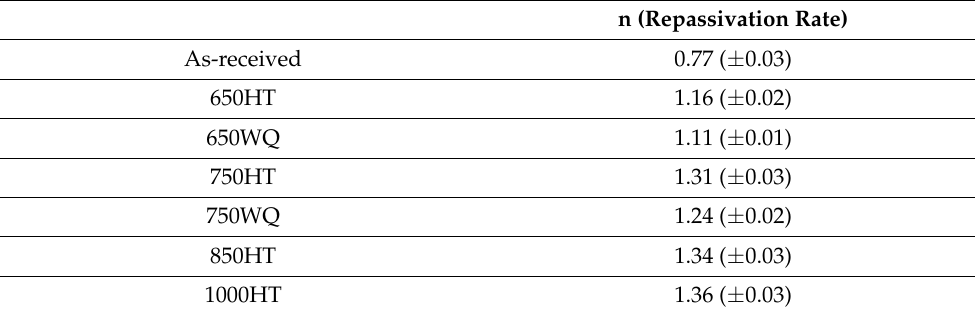
Table 6. Values of the repassivation rate n, obtained from the linear region slope of log i ( t ) vs. log t representation, for the as-received and heat-treated AM Ti